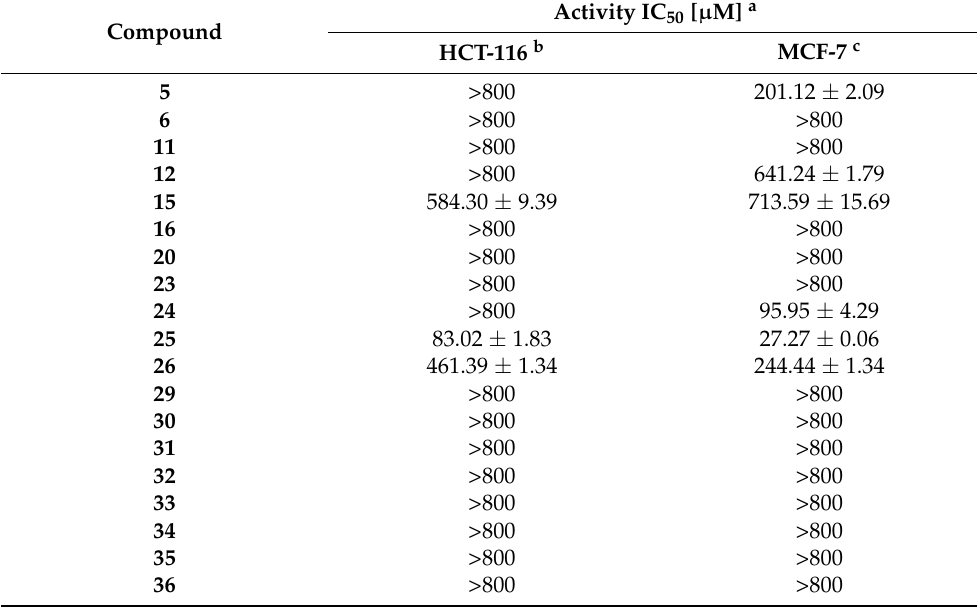
Table 1. Summary of cytotoxicity of substrates used for glycoconjugation and metabolites of sugar derivatives.